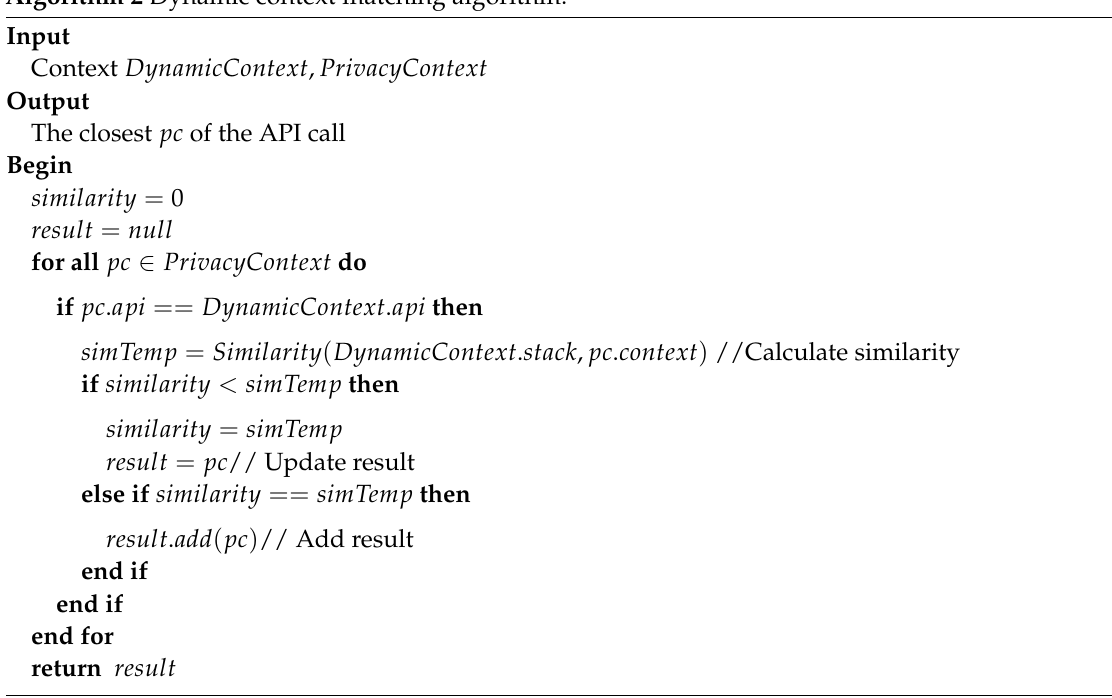
Algorithm 2 Dynamic context matching